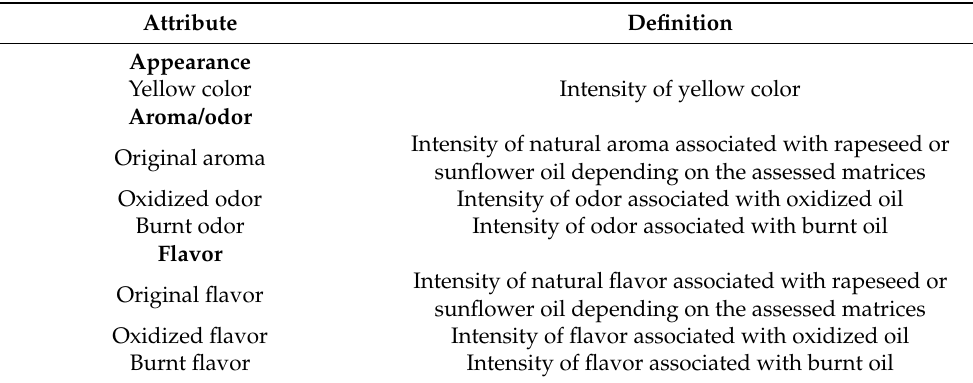
Table 2. Attributes for quantitative descriptive analysis of fortified cold-pressed rapeseed and sunflower oils and their